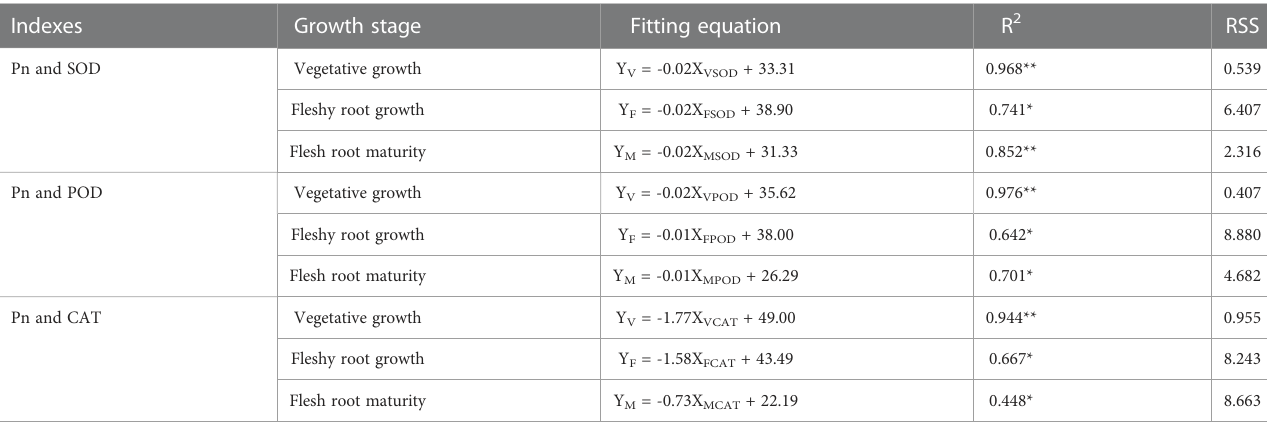
TABLE 4 The fi tting equation, coef fi cient of determination (R 2 ), and residual sum of squares (RSS) of Pn and antioxidant enzyme activity of woad under water de fi cit at different growth stages.